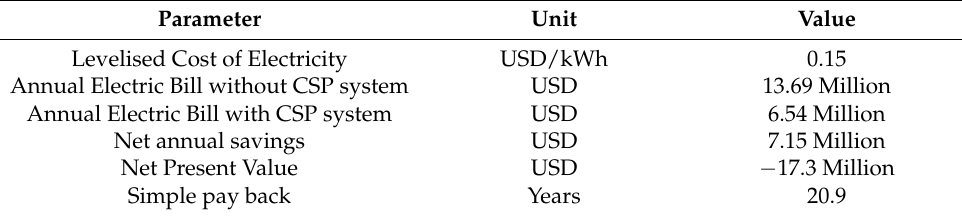
Table 18. Economic performance indicators for the CSP and TES system.